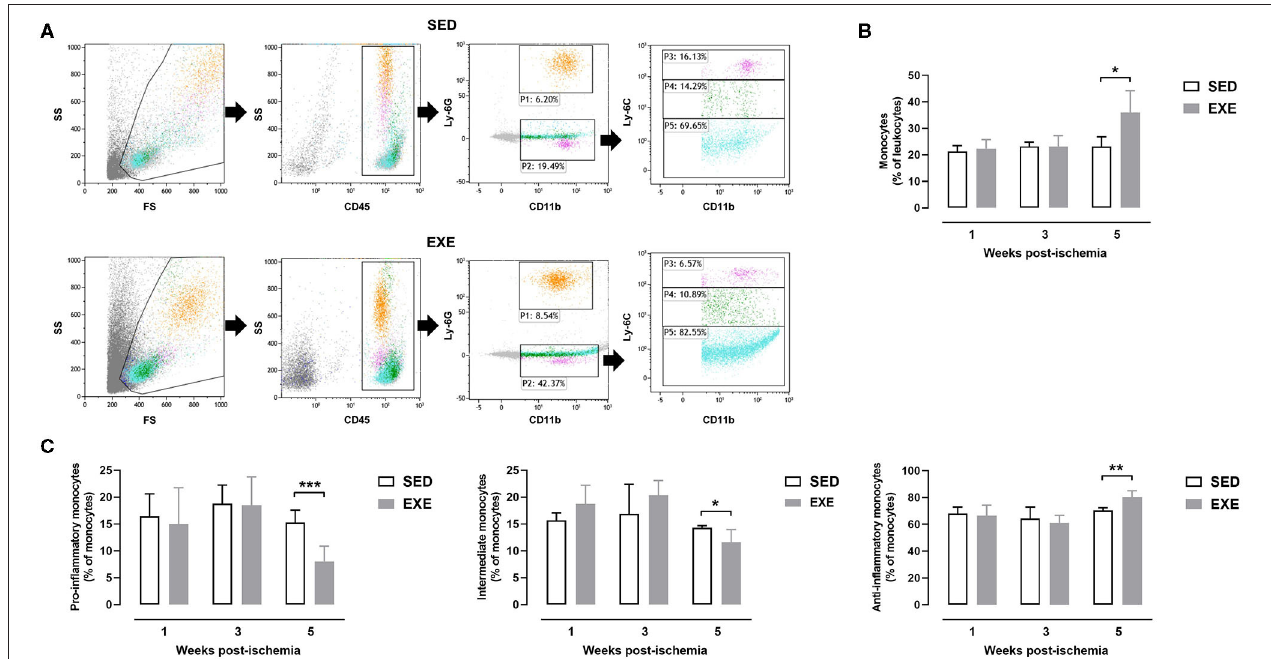
FIGURE 7 | Effect of preventive exercise on circulating monocytes of ApoE − / − mice with PAD. (A) Example of gating strategies to identify monocyte subsets in SED and EXE mice. First, viable cells were gated on Forward Scatter (FS)/Side Scatter (SS). Next, a CD45/SS plot was created within the viable cells to identify leukocytes (CD45 + cells). Granulocytes were identified as CD11 + Ly6G + cells (P1), while monocytes were identified as CD11 + Ly6G − cells (P2). Monocytes were further gated for expression of Ly6C, after which three distinct subpopulations of monocytes were categorized as follows: classical proinflammatory monocytes (CD11 + Ly6G − Ly6C hi ), intermediate monocytes (CD11 + Ly6G − Ly6C int ) and non-classical anti-inflammatory monocytes (CD11 + Ly6G − Ly6C low ). (C) The percentage of monocytes within the leukocyte population ( B) and of each monocyte subtype within the monocyte population were compared in SED and EXE mice at 1 week, week 3, and week 5 post-ischemia ( n = 4 to 11 animals per group). Unpaired t -test in (B,C) : * p < 0.05, ** p < 0.01, and *** p < 0.001 vs. SED. Bar graphs represent mean ±